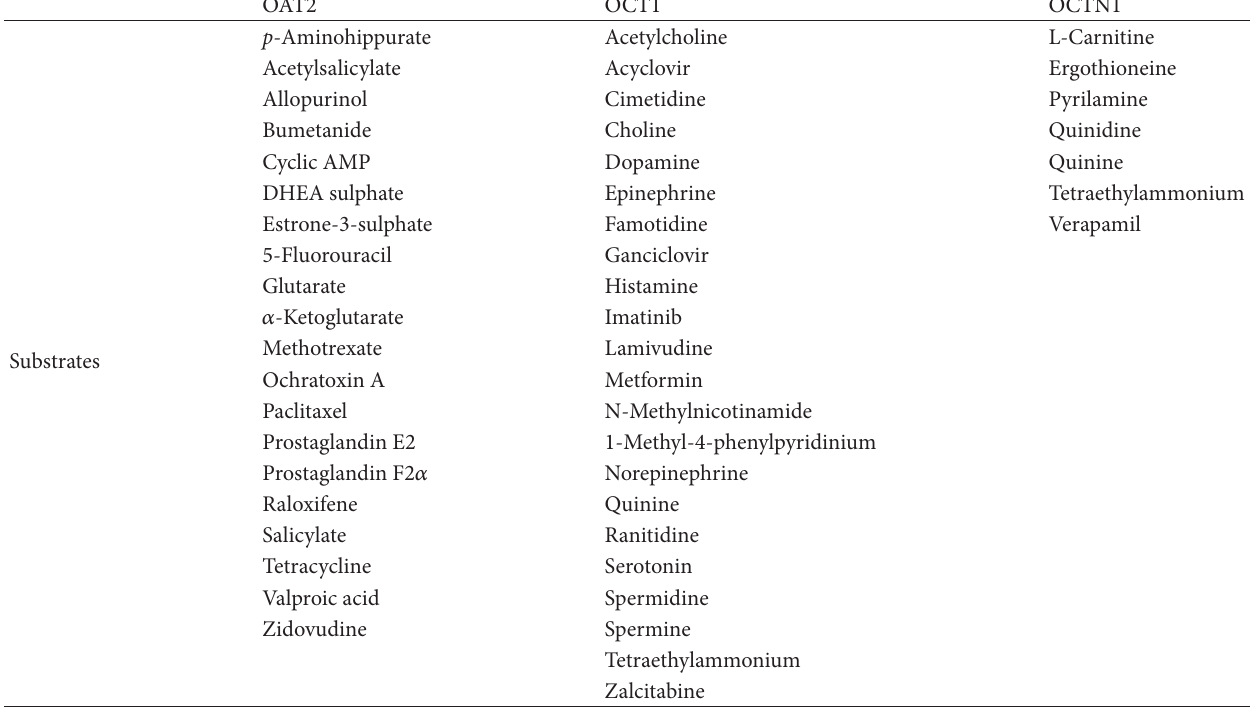
T 2: Identi�ed potential substrates of hepatic forms of OATs, OCTs, and OCTNs with pharmacological